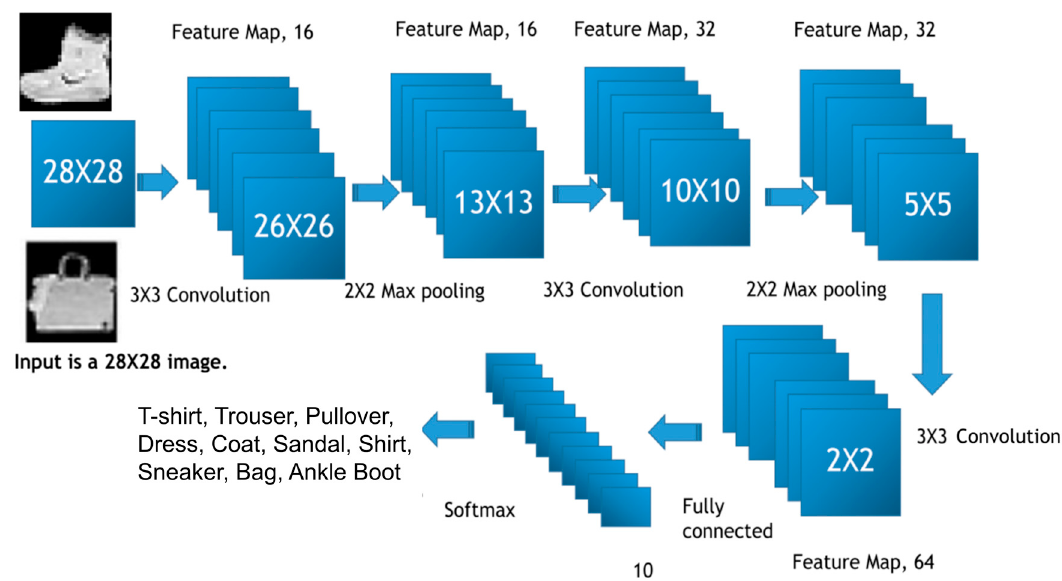
Figure 3. Convolution neural network architecture for image classification using Fashion-MNIST data .